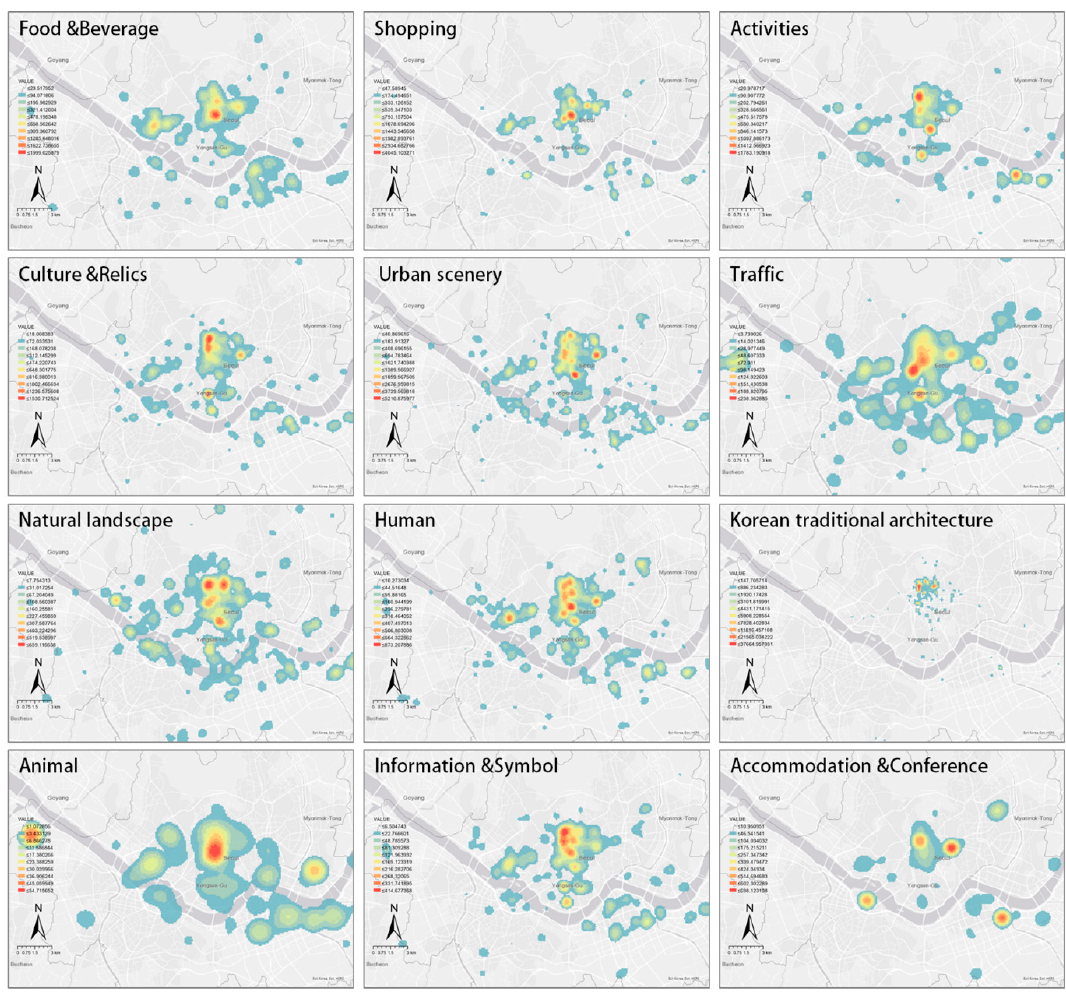
Figure 13. Kernel density map by category.